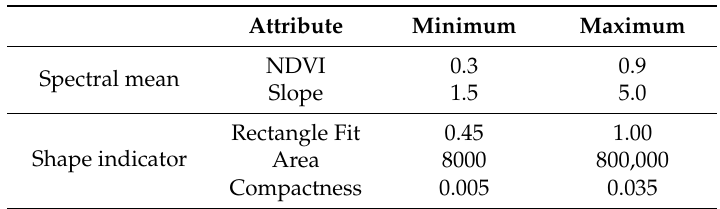
Table 2. Value range used for crop extraction.